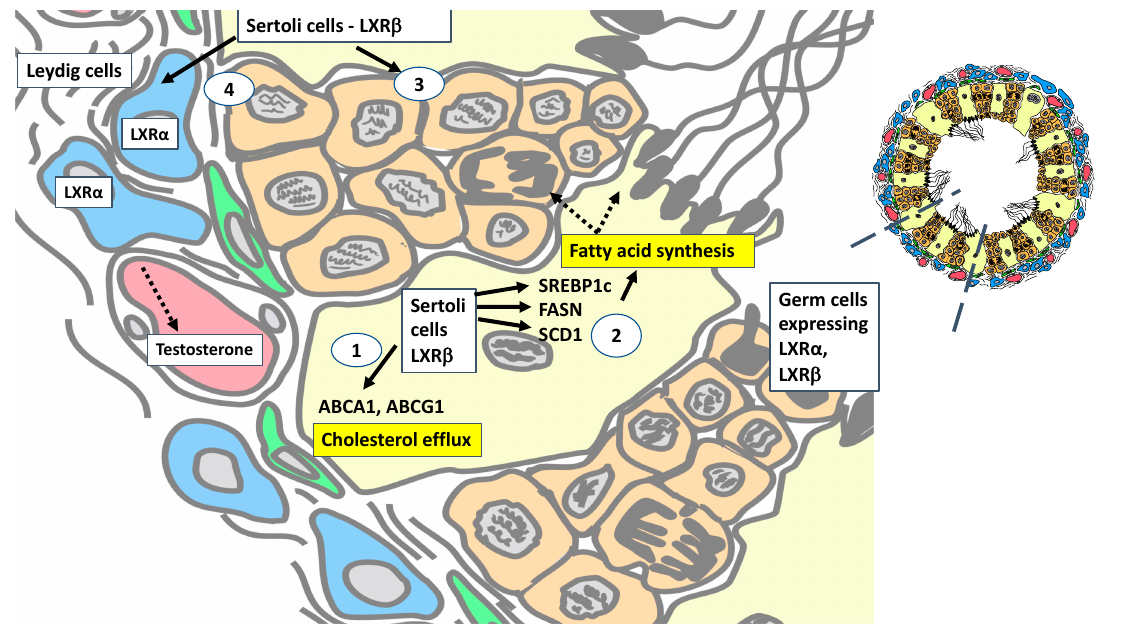
Figure 2. Schematic representation of seminiferous tubule and interstitium illustrating main roles of LXRs in the testis. LXR α is expressed in Leydig cells and LXR β is expressed in Sertoli cells. Male germ cells express both isoforms. LXR β regulates expression of genes important for lipid homeostasis processes such as (1) cholesterol e ffl ux notably ABC transporters ABCA1, ABCG1 which reduce cellular cholesterol levels (2) fatty acid synthesis genes SREBP1c, SCD1, FASN and fatty acids. which are used by Sertoli cells but also maturing germ cells as fuel (3) LXR β is important for maintenance of the blood testis barrier and (4) LXR β regulates the endocrine function of Leydig